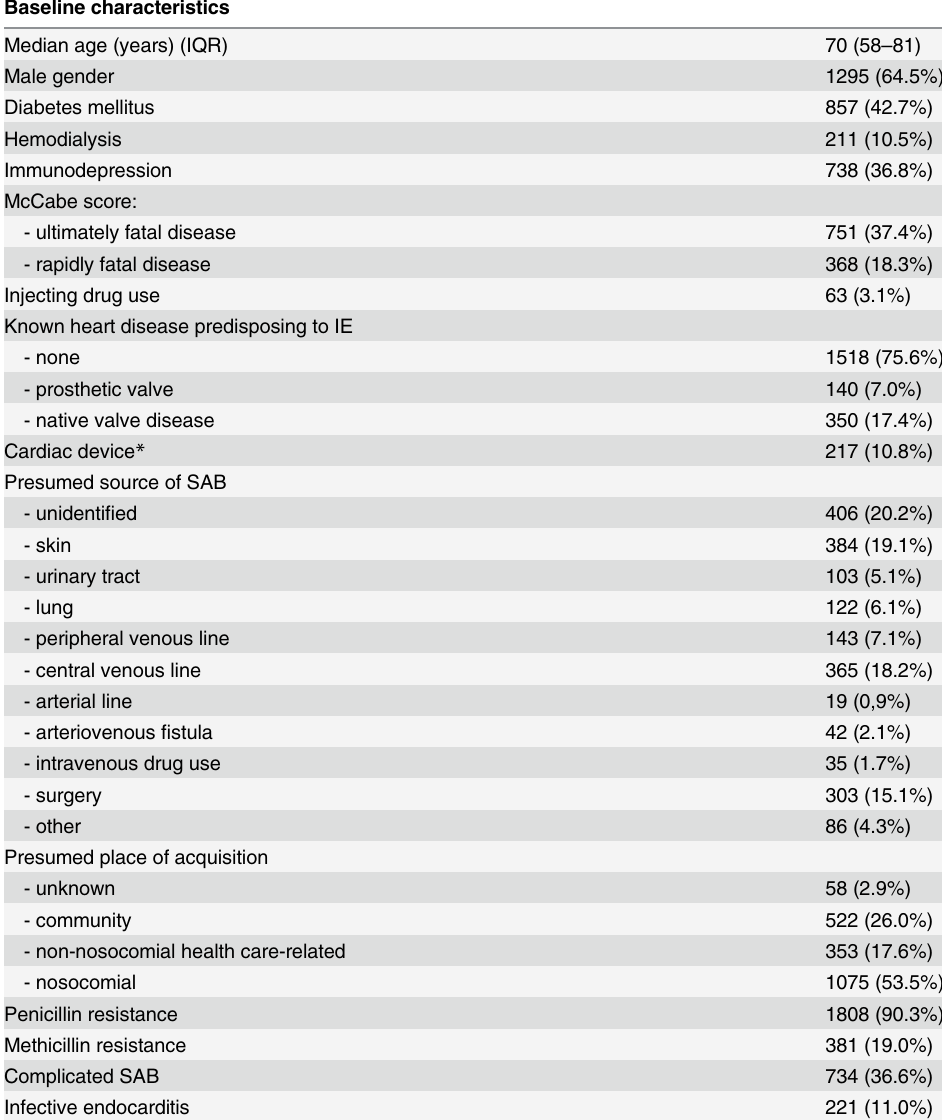
Table 1. Main characteristics of the 2008 patients with Staphyloccus aureus bloodstream infection en- rolled in the VIRSTA study, 2009 – 2011. Baseline